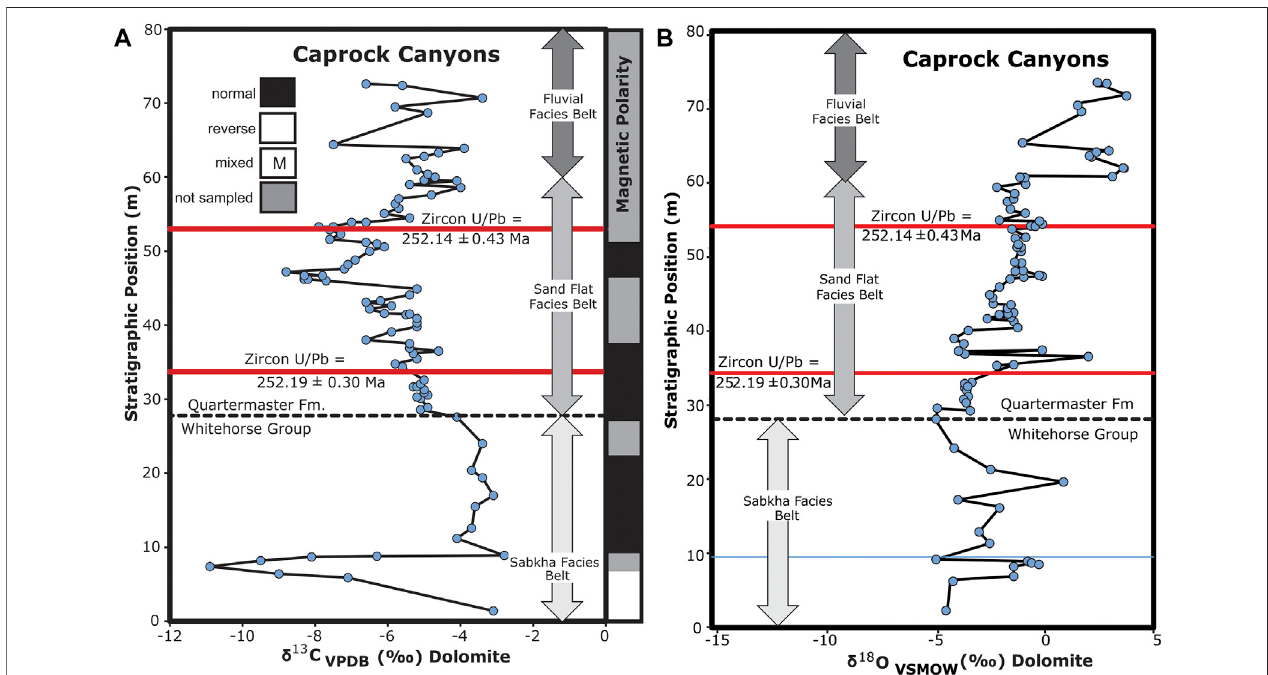
FIGURE 13 | (A) Chemostratigraphic chart of the stratigraphic position vs. dolomite δ 13 C value of dolomicrite cements from the Caprock Canyons stratigraphic section. (B) Chemostratigraphic chart of the stratigraphic position vs. dolomite δ 18 O value of dolomicrite cements from the Caprock Canyons stratigraphic section. Red lines and black dashed line in both graphs represent the position of volcanic ashes and the stratigraphic boundary between the lower Whitehorse Group strata and the upper Quartermaster Formation strata, respectively. See text for detailed